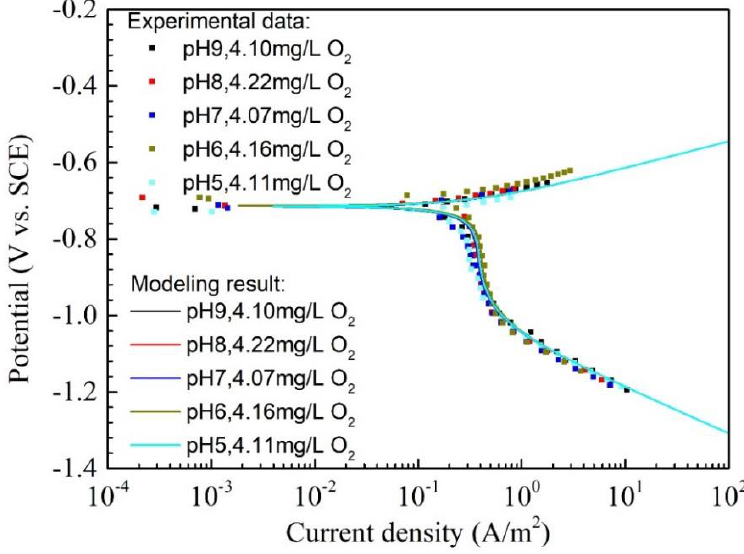
Figure 7. The polarization curves and modeling results of Q345R steel in 1 wt.% NaCl solution containing 4.07 to 4.22 mg/L oxygen at different pH under 30 °C. Square: experimental data. Solid line: modeling result.